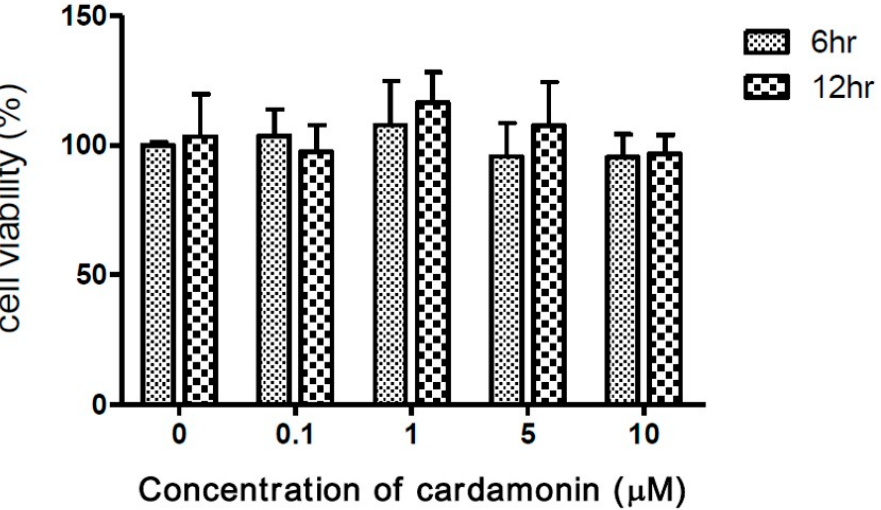
Figure 1. Effects of cardamonin on viability of J774A.1 macrophage cells following incubation with 0–10 μ M of cardamonin for 6 or 12 h. Each value represents the mean ± SD of four independent experiments.